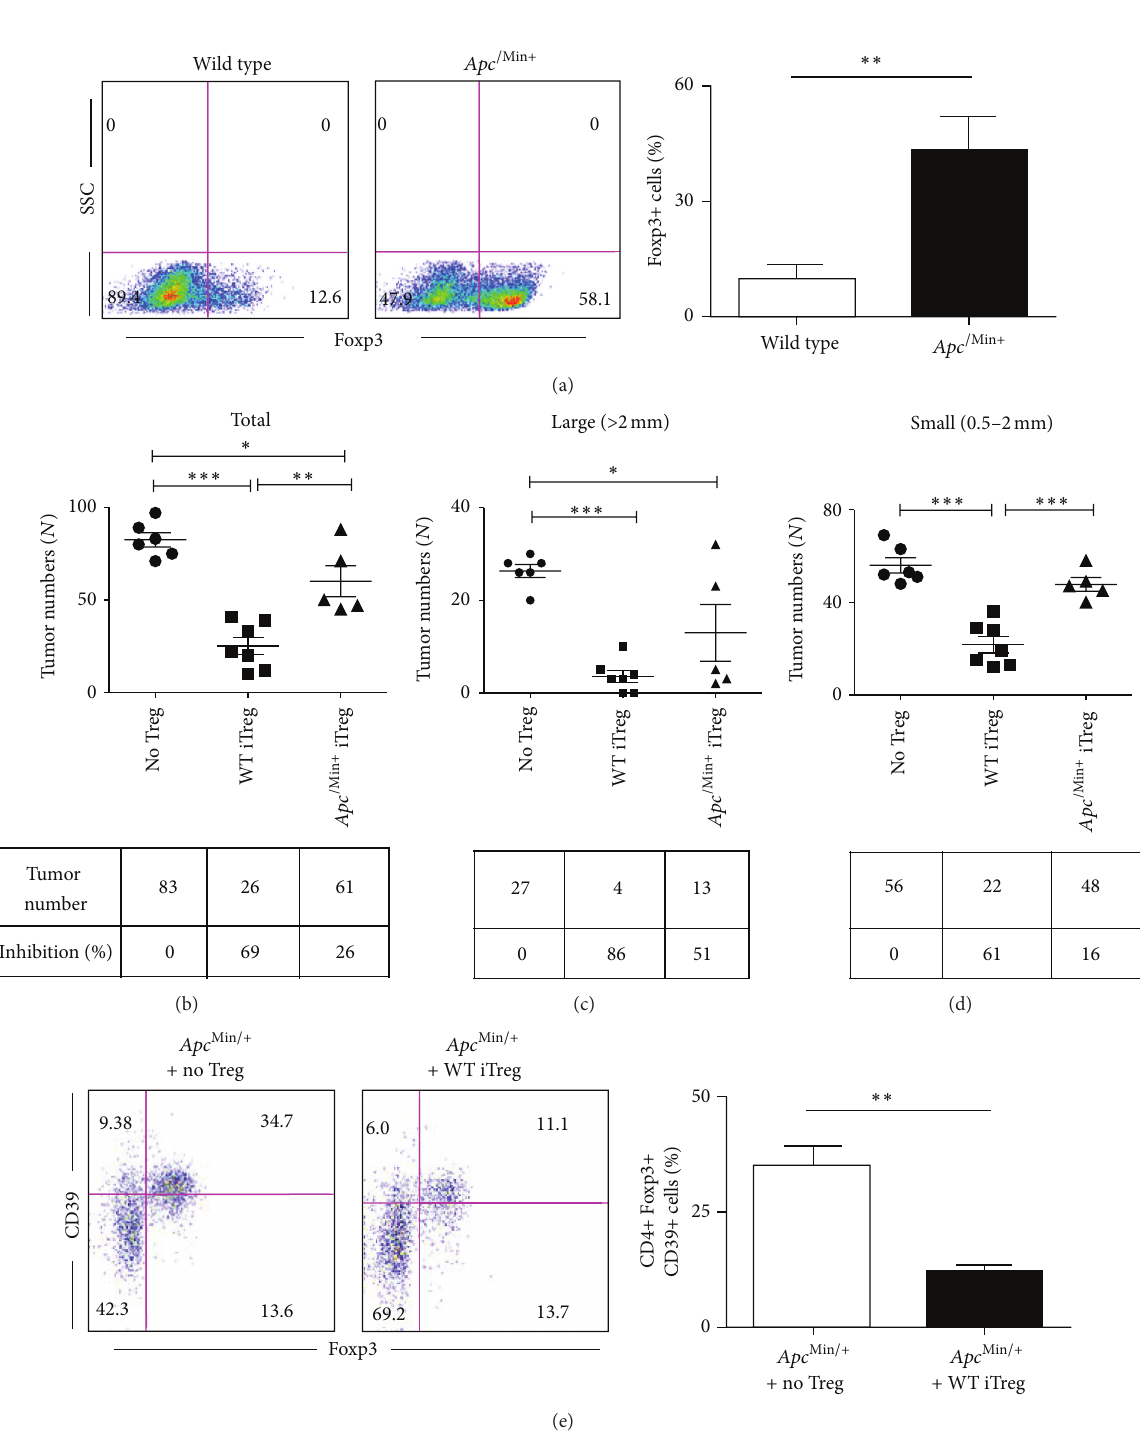
Figure4:WildtypeinducibleTregscanregressintestinaltumorsin 𝐴𝑝𝑐 Min /+ mice. (a)Splenicna¨ıveCD4Tcellsfrom6-7-week-old 𝐴𝑝𝑐 Min /+